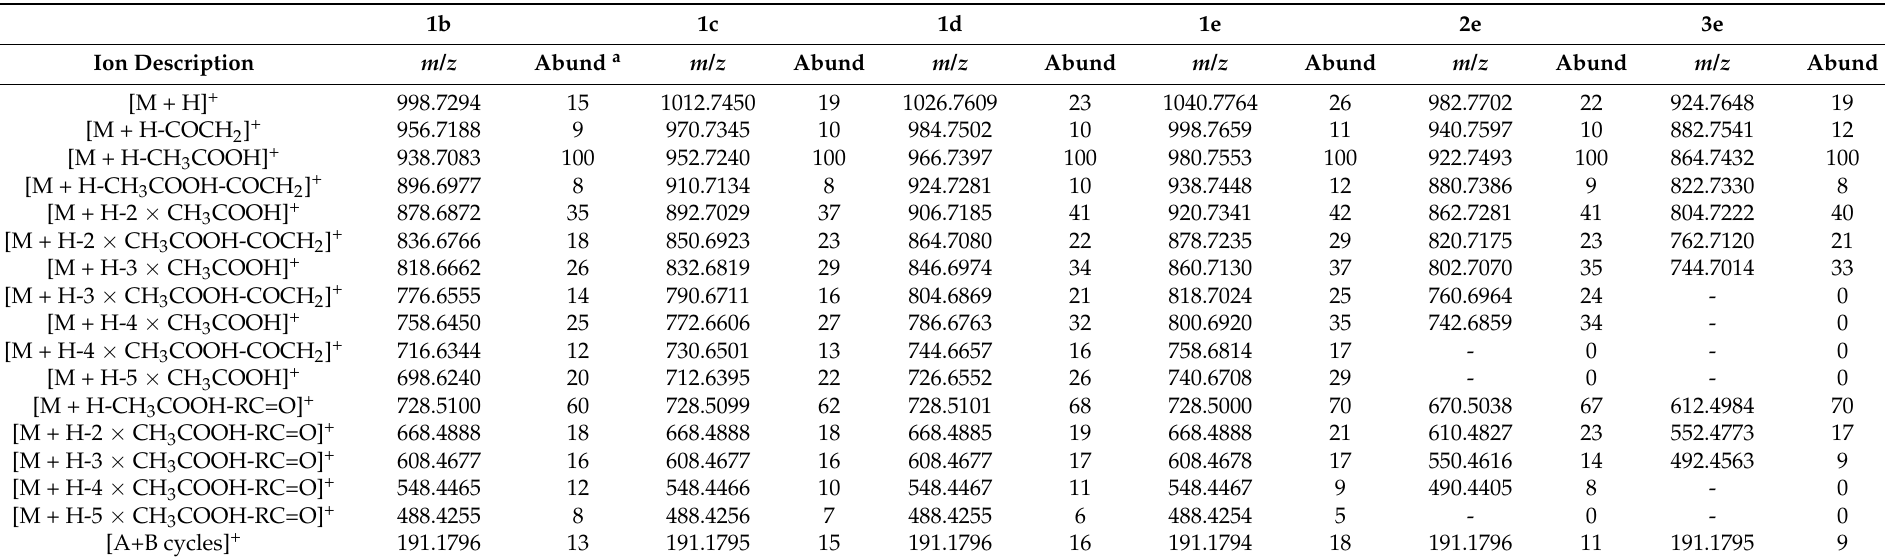
Table 1. Assignment of ions observed in tandem high-resolution electrospray mass spectra of hopanoids described in the